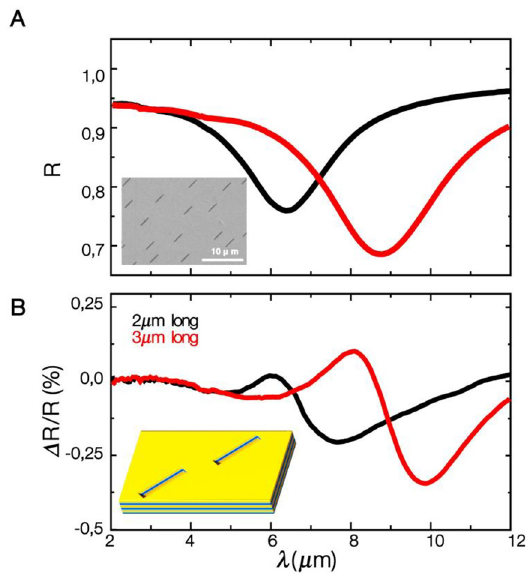
Figure 12: MRE mediated magnetic modulation of slits localized plasmons in the mid IR. (A) Reflectivity spectra for random arrays of slits fabricated on a Ni 81 Fe 19 /Au multilayer with 3.8 % GMR, for two different slit lengths 2 μ m (black line) and 3 μ m (red line), respectively.Theslitwidthisinbothcases0.3 μ m.Lightispolarized perpendicular the slit long axis and the dips in the re fl ectivity correspondtotheexcitationoftheslitlocalizedplasmonresonance. TheinsetshowsanSEMimageofthe3 μ mslit array.(B)MREspectra ( Δ R/R=(R P -R AP )/R AP ) for the same slit arrays (black line: 2 μ m slit length,red line:3 μ m slit length).Lightis polarized perpendicular to the slit long axis. The spectra show a derivative like feature at the position of slit resonance superimposed to a broad band originated from the multilayer. The insetshowsa schema of the slitsfabricated on a Ni 81 Fe 19 /Au multilayer.